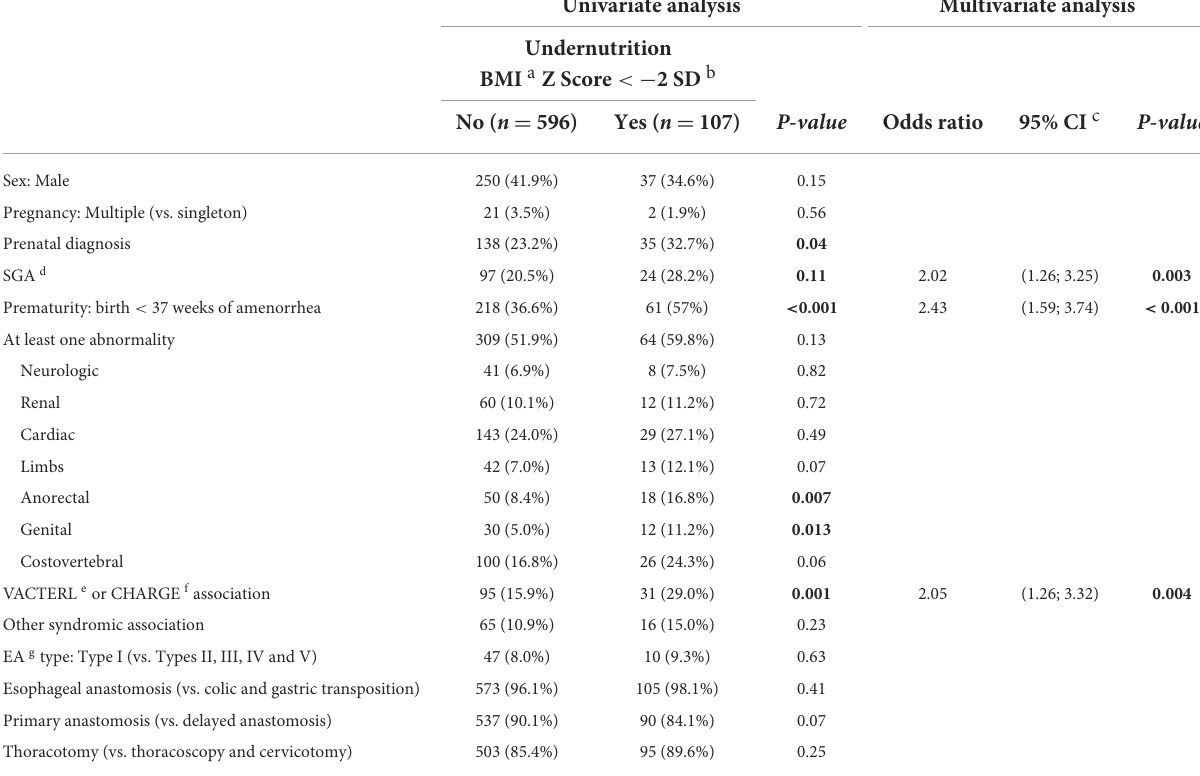
TABLE 3 Predictive factors for undernutrition at age 1